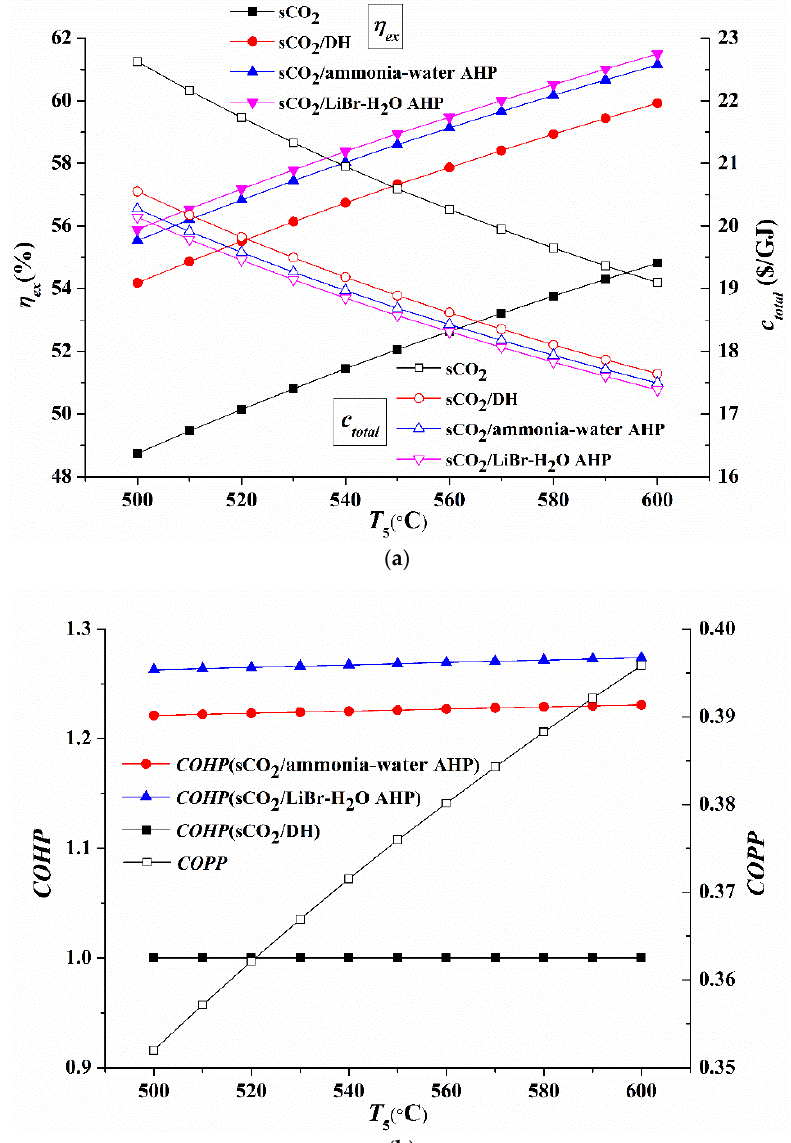
Figure 4. Variation trends of system performance indicators with T 5 for different thermal systems: ( a ) η ex and c total ; ( b ) COPP and COHP .